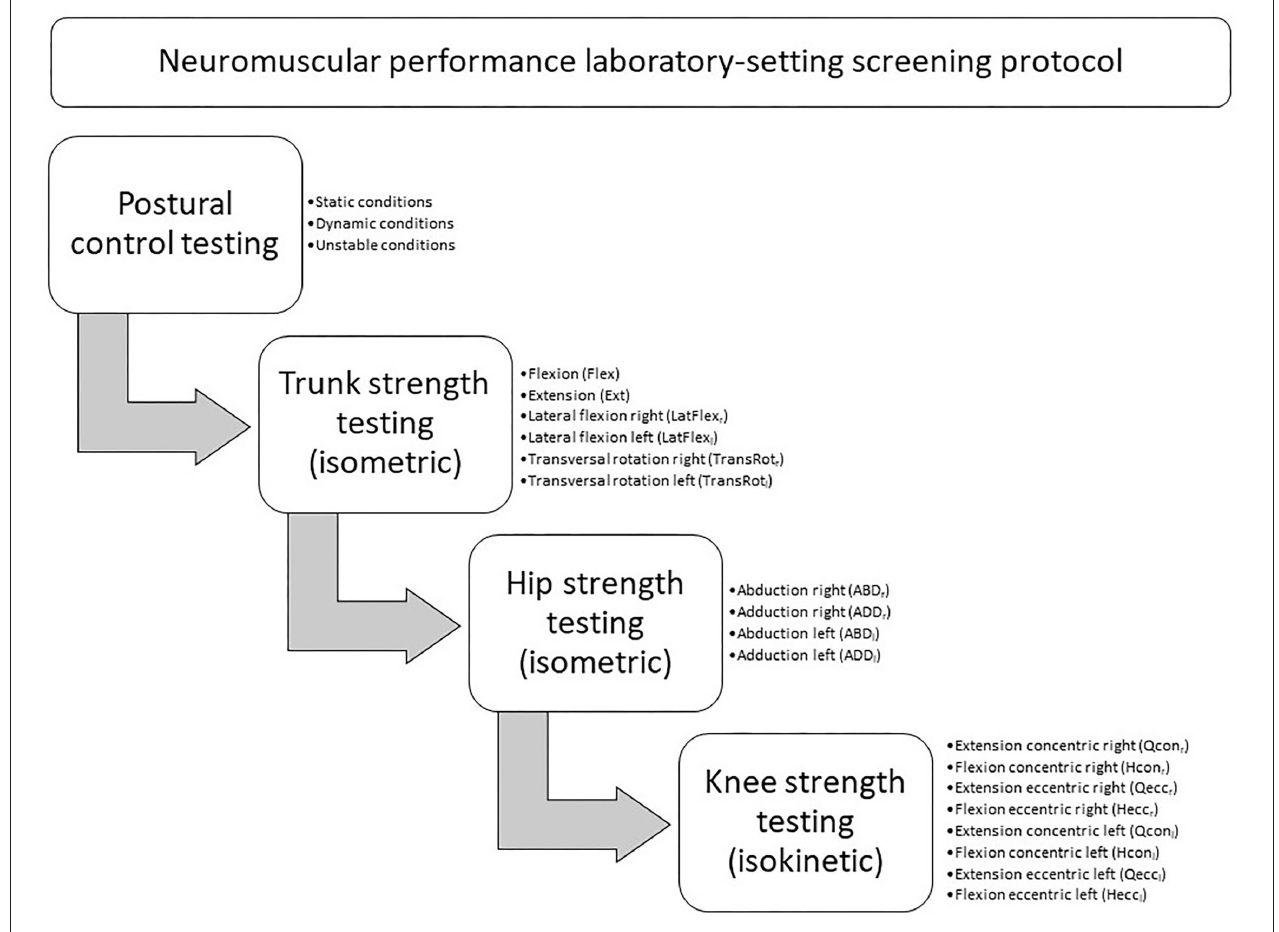
FIGURE 1 | Neuromuscular performance laboratory-setting screening